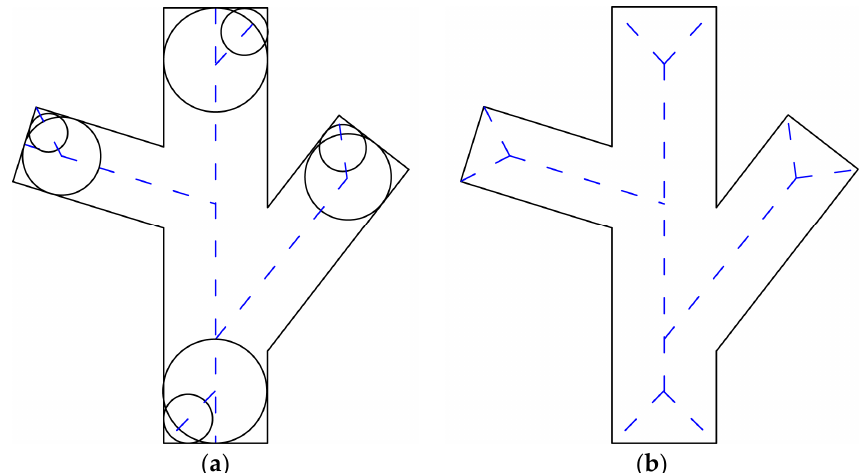
Figure 2. Schematic diagrams of the morphological skeleton algorithm showing ( a ) different positions of maximum disk sizes and ( b ) the whole skeleton, indicated with dashed lines.